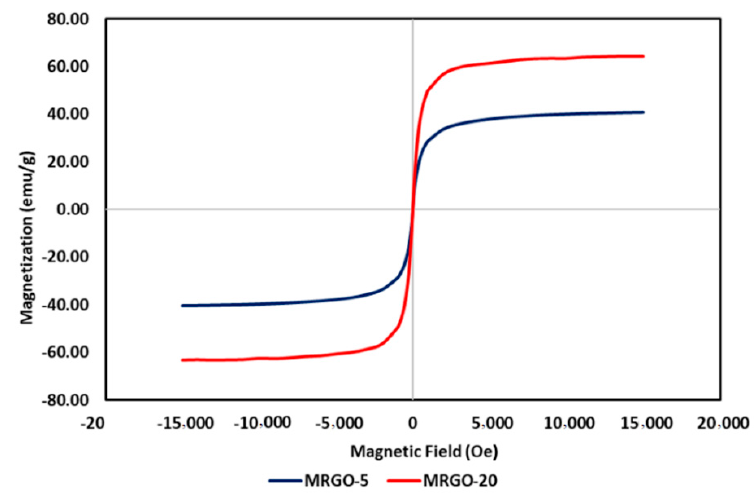
Figure 8. VSM analysis of MRGOs.